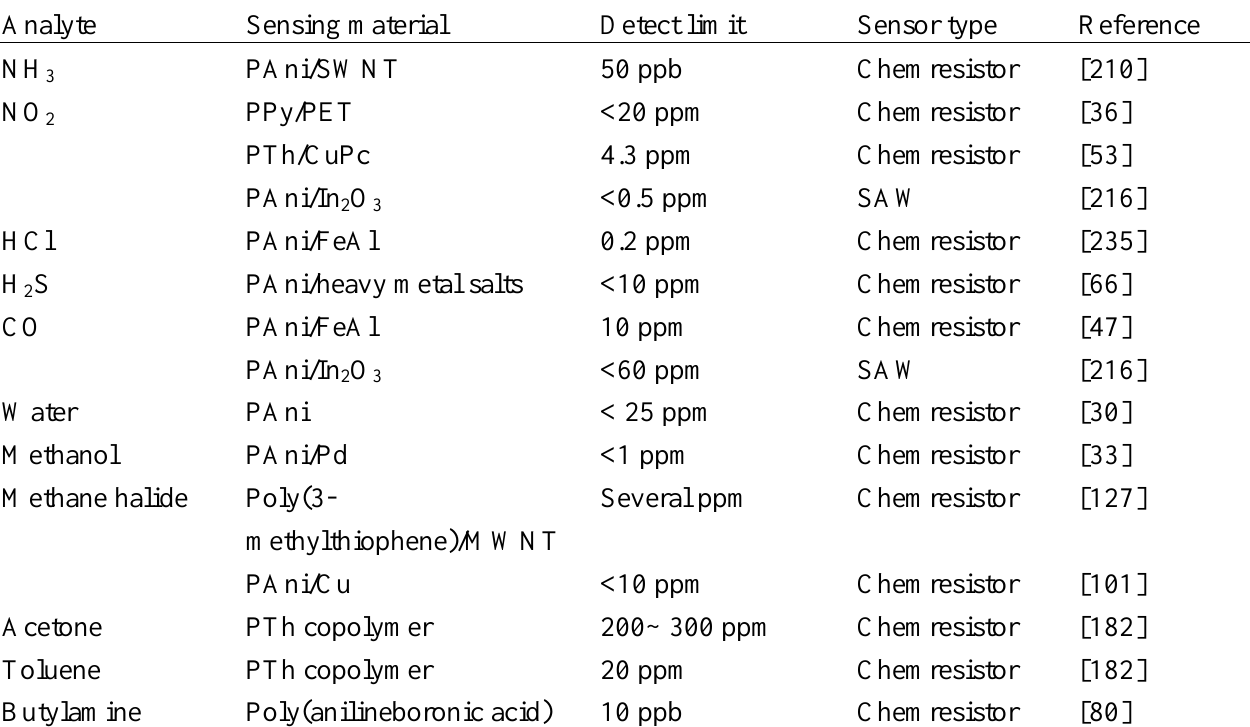
Table 3. Detect limits of sensors based on conducting polymers and their composites to several gas